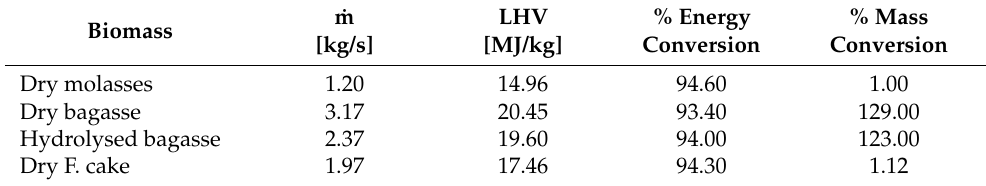
Table 6. Stoichiometric carbon capturing efficiency in biomass to syngas conversion process.